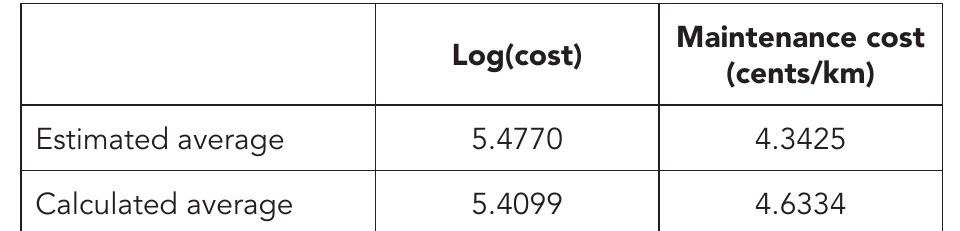
Table 1: Model evaluation – separate data sets (Carstens, 2000: 239)